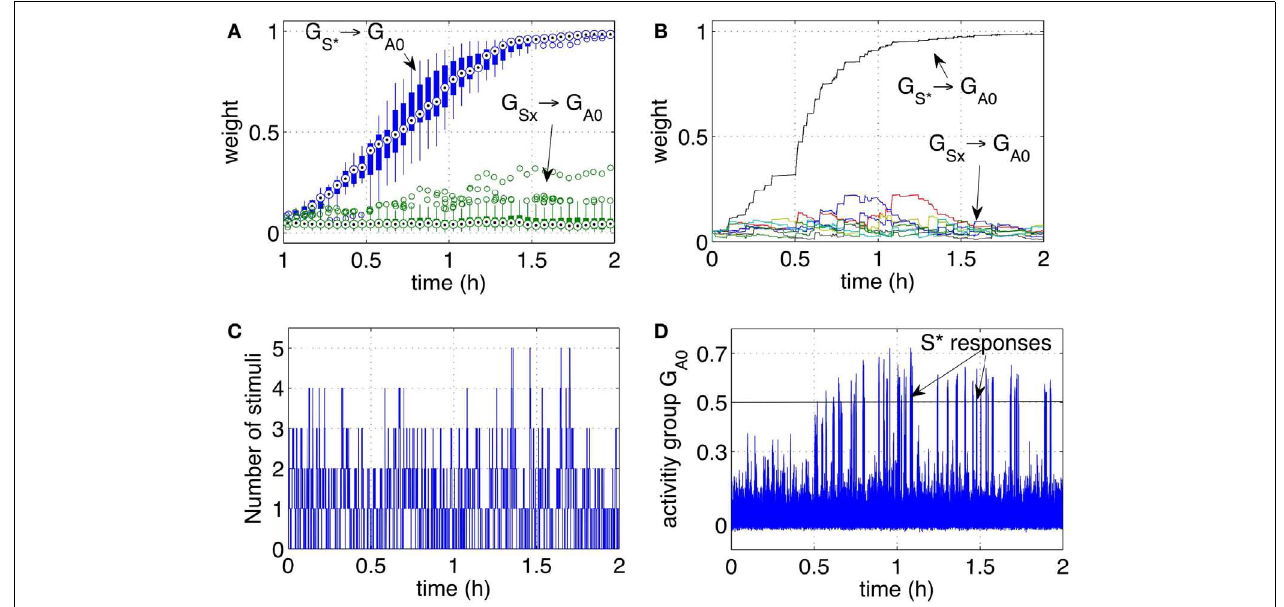
lines from 10 runs) grows consistently during the learning process and across all independent runs.The pathways from disturbing stimuli (box plots from eight lines for each run, i.e., 80 lines) remain at low values. (B) The strength of the pathways as in (A) are shown in one particular run. (C) Number of stimuli present at any time during one particular run. (D) The activity of the output group G A 0 during one particular run.The network increases its responses as the stimulus S ∗ becomes progressively associated with the